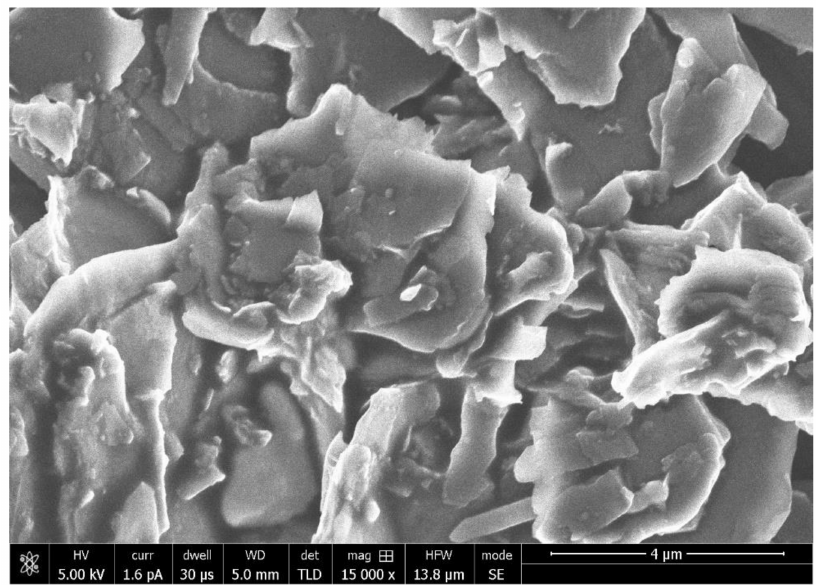
Figure 1. SEM image of graphene oxide. Graphene oxide showing variable size flakes with 1–2 nm thickness. These nanoparticles on SEM shows uniform and tight agglomerations for graphene oxide flakes.